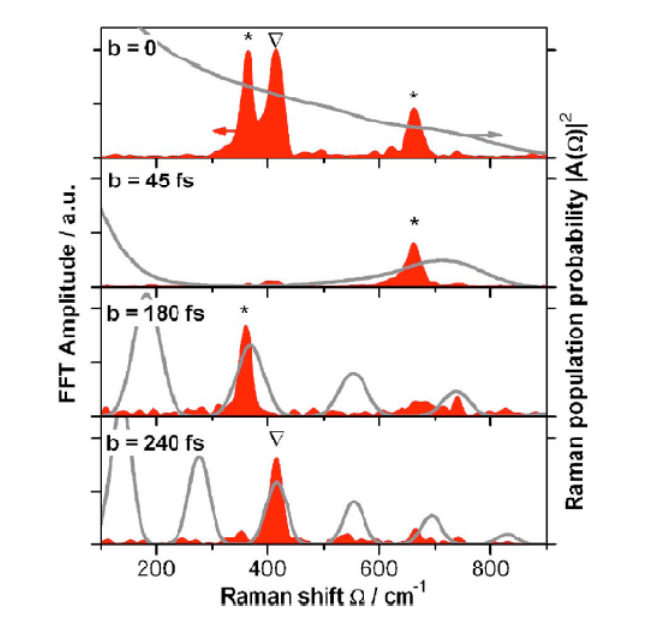
Figure 11. fs CARS spectra from [57]. Control results for molecular vibrations selectively excited in a binary mixture of CHCl and CBrCl with time-resolved single beam CARS. A 3 3 suitable multipulse spacing b achieves full selectivity and control over all the accessible modes of CHBr (marked “  ”) and CHCl (marked “*”). Reprinted from von Vacano et 3 3